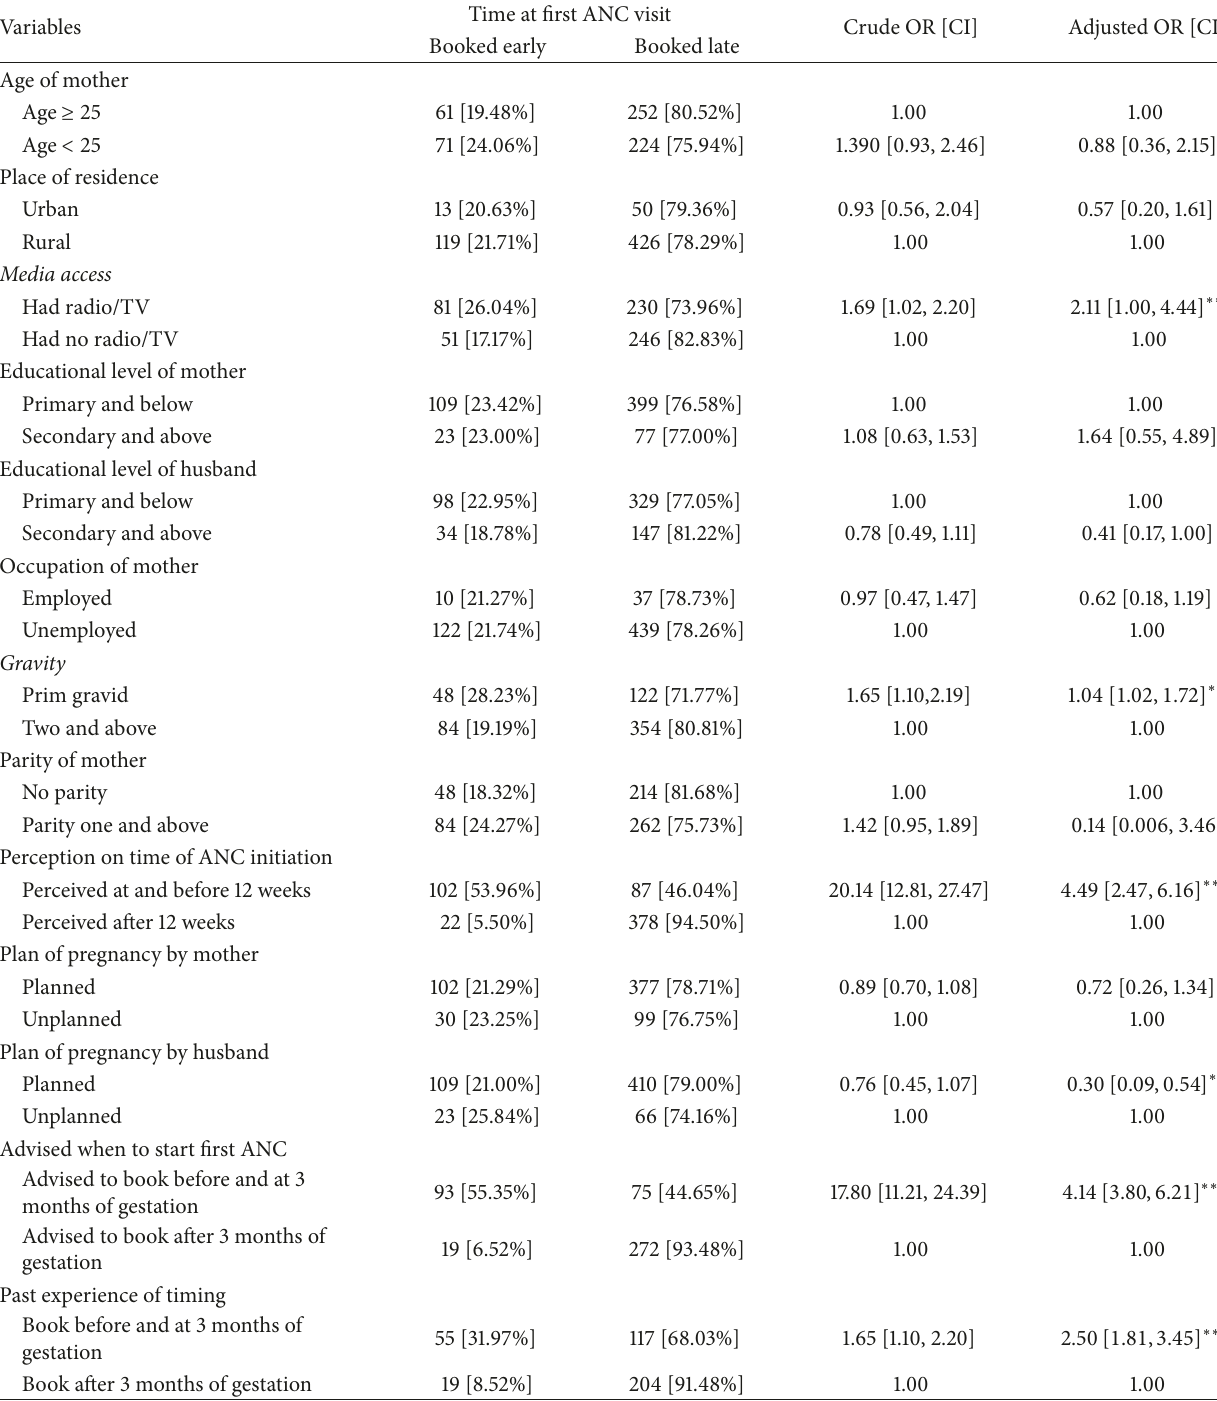
Table 4: Association of factors with timely booking of first ANC, Shebedino district in